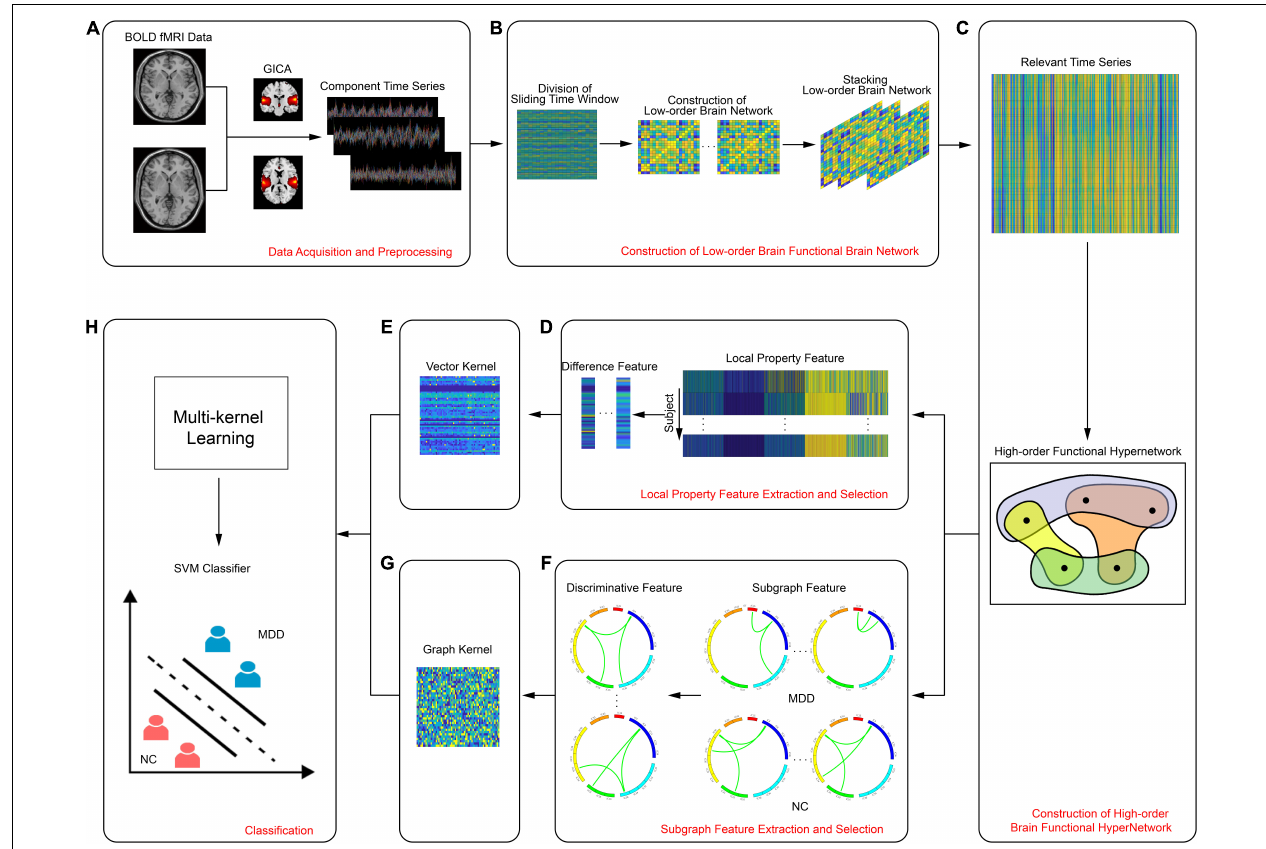
FIGURE 1 | Flowchart showing the experimental process, including (A) data acquisition and preprocessing, (B) construction of low-order brain functional brain network, (C) construction of high-order brain functional hypernetwork, (D) local property feature extraction and selection, (E) vector kernel, (F) subgraph feature extraction and selection, (G) graph kernel, (H) classification.